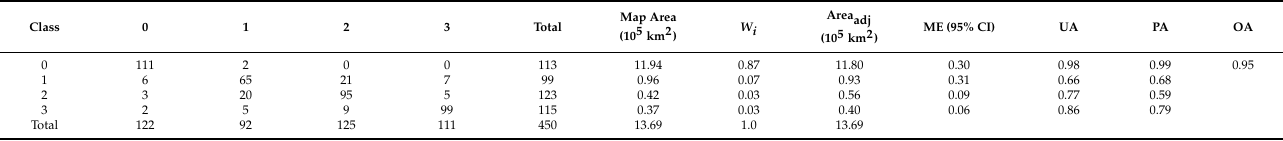
Table 3. Error matrix of sample counts (n ij ) constructed from the accuracy assessment. Map categories are the rows while the reference categories are the columns. Note: Class 0: no damage (<5% loss), 1: light damage (5–20%), 2: moderate damage (20–50%), 3: severe damage (>50%); Area adj :